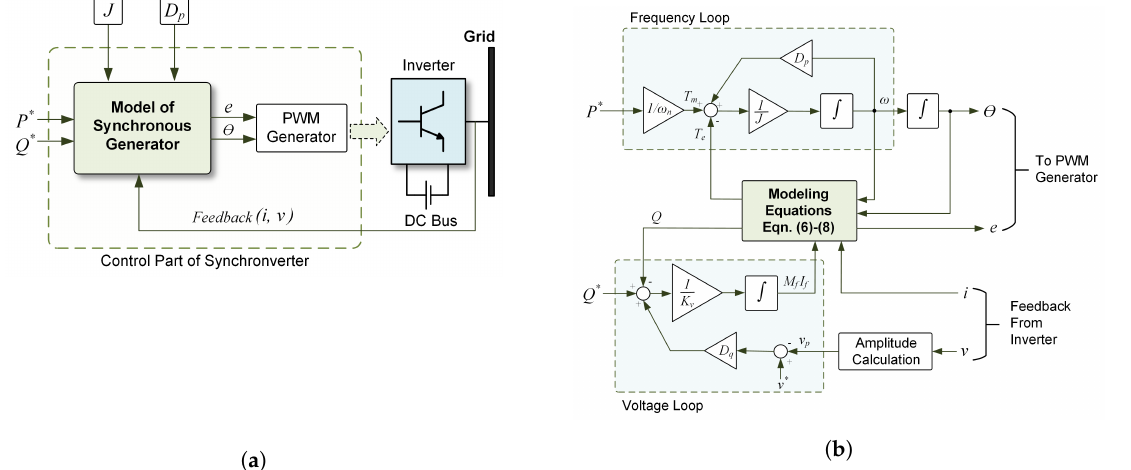
Figure 7. Synchronverter topology: ( a ) overall schematic showing operating principle; ( b ) detailed control diagram showing the modeling